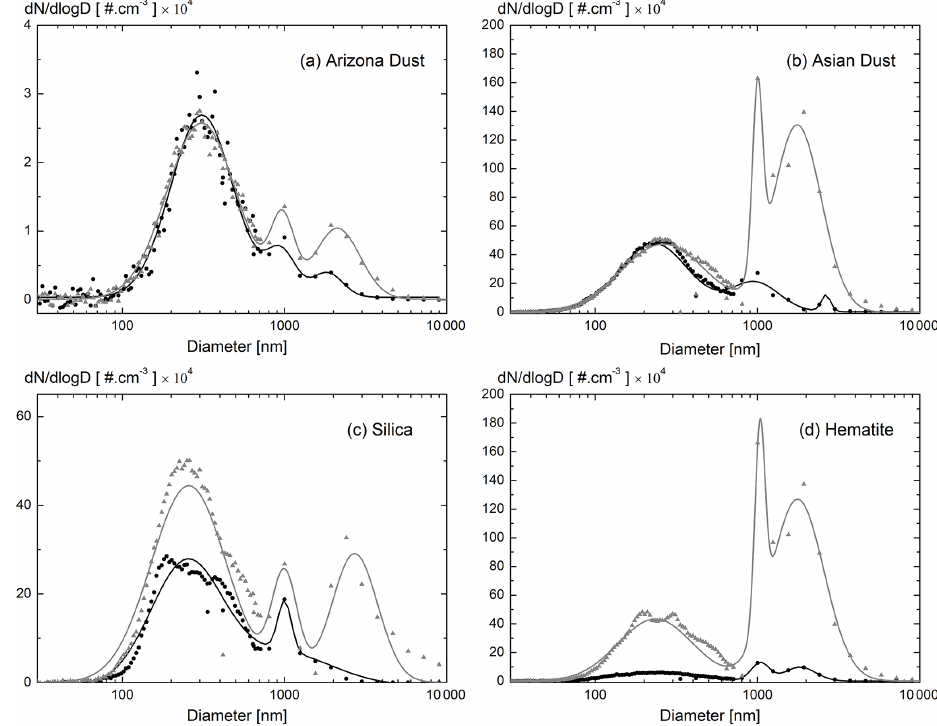
Figure 1. Dust particle size distributions (SDs) for (a) Arizona dust, (b) Asian dust, (c) Silica (SiO 2 ) and (d) Hematite (Fe 2 O 3 ) in the presence/absence of the added cyclone (finer SD in solid black, coarser SD in dotted gray). The retrieved SDs, obtained by log-normal adjustments, agree with the specifications provided by the